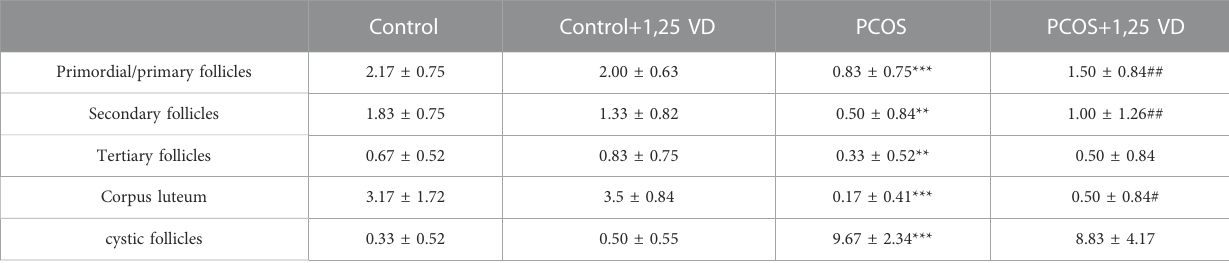
TABLE 1 Description of the ovarian